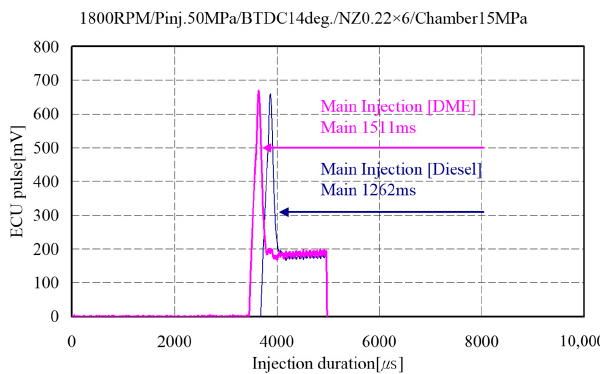
Figure 3. Two-way valve control signals for fuel injection without pilot injection for DME and diesel.